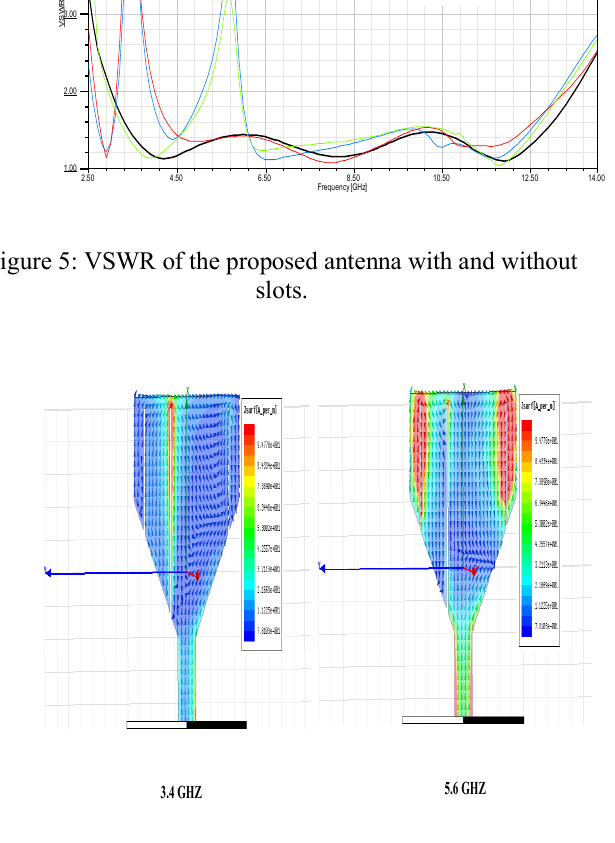
Figure 6: Simulated current density distribution of the antenna at 3.5 and 5.6